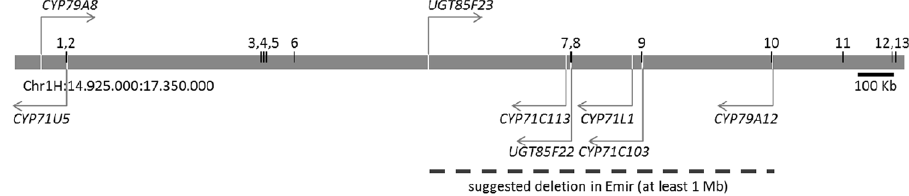
Figure 1. Genomic organization of the barley hydroxynitrile glucoside biosynthetic gene cluster on chromosome 1H. Arrows indicate orientation on the forward (right) or reverse (left) strand. Numbers above the cluster indicate SNP marker positions listed in Supplementary Fig. S1. Kb: kilobase. Mb: megabase. Accession numbers: CYP79A8 , HORVU1Hr1G007400; CYP71U5 , HORVU1Hr1G007420; UGT85F23